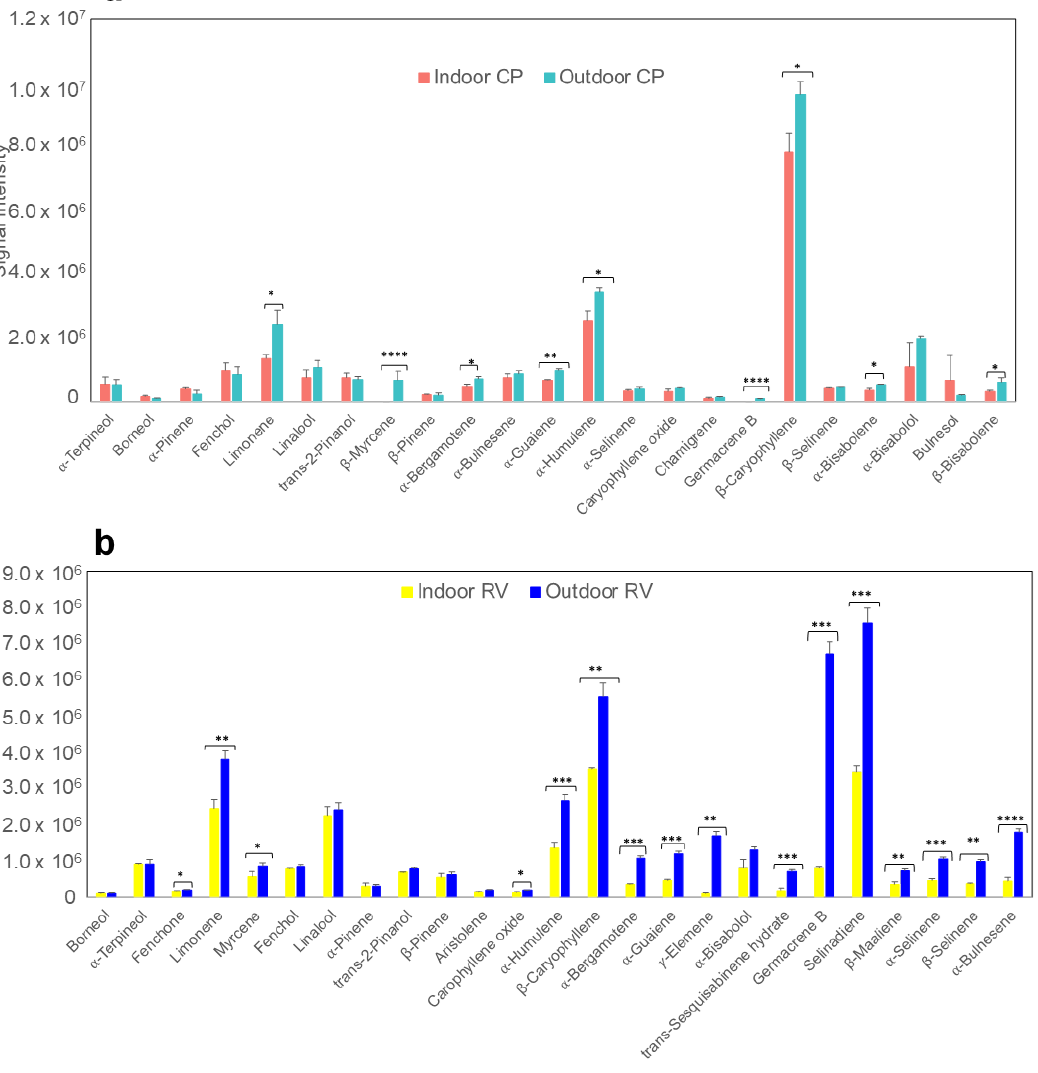
Figure 5. Identified terpenes from targeted GC-MS analysis in ( a ) CP-indoor and CP-outdoor, ( b ) RV-indoor and RV-outdoor. Data are plotted as the average ± SD, n = 3 individual samples; **** p < 0.0001, *** p < 0.001, ** p < 0.01, * p < 0.05 as calculated by t-test.